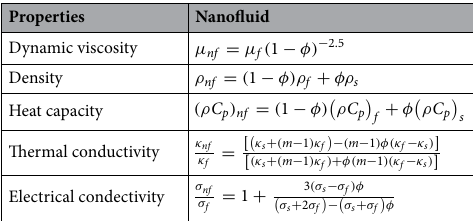
Table 1. Thermophysical attributes for Jeffrey nanofluid.